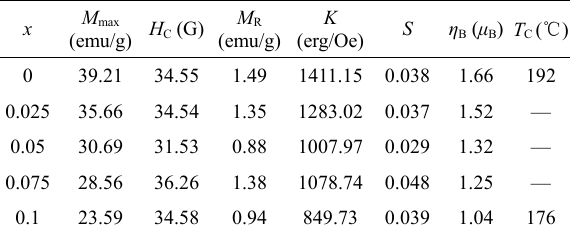
Table 6 Values of M max , H C , M R , K , S , η B , and T C for